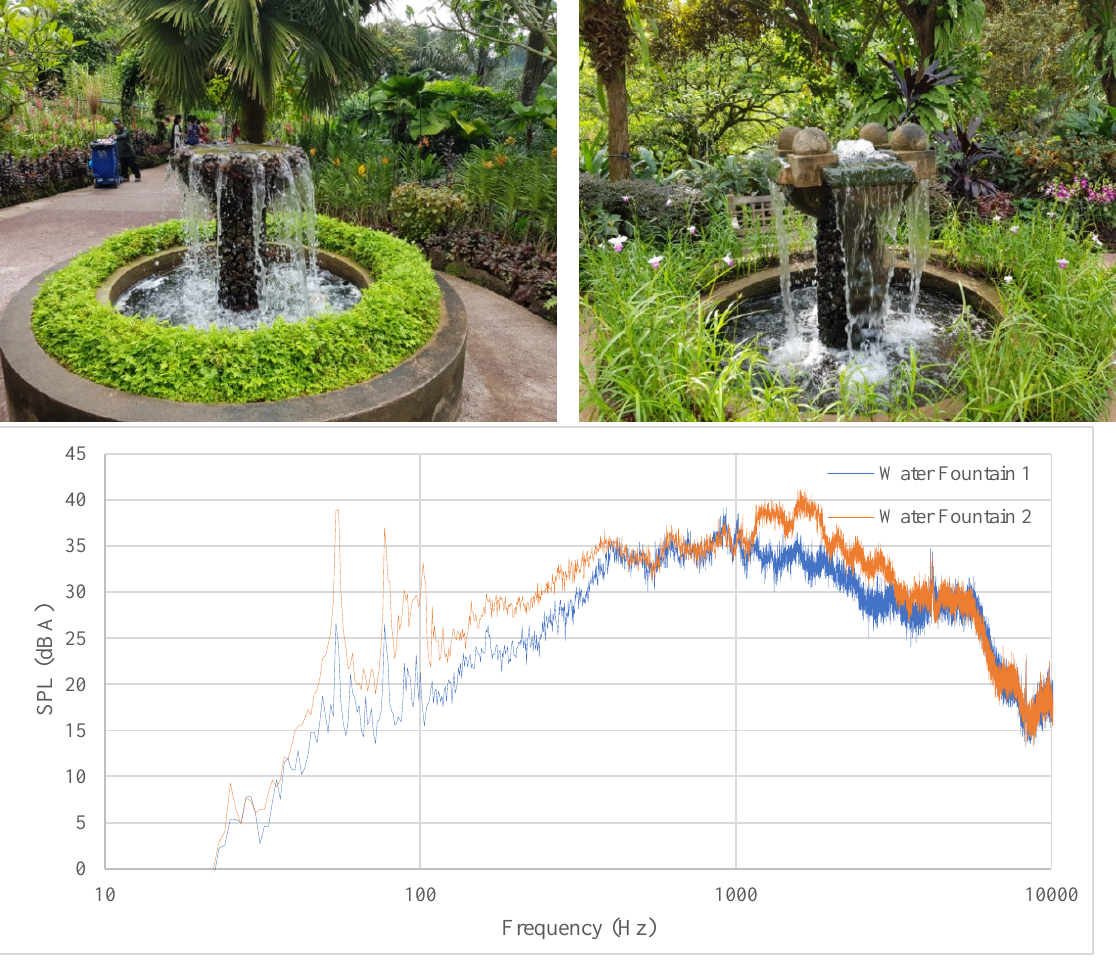
Figure 8: Two water fountains at the Orchid Gardens and their average frequency spectrums in dBA